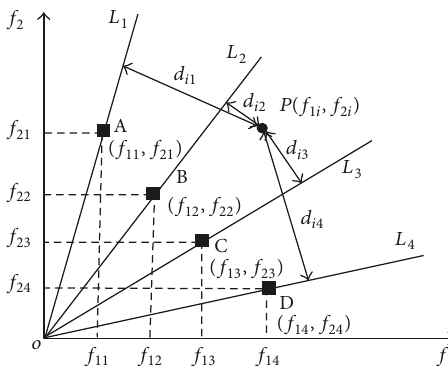
Figure 5: Finding the global best guide for each particle.